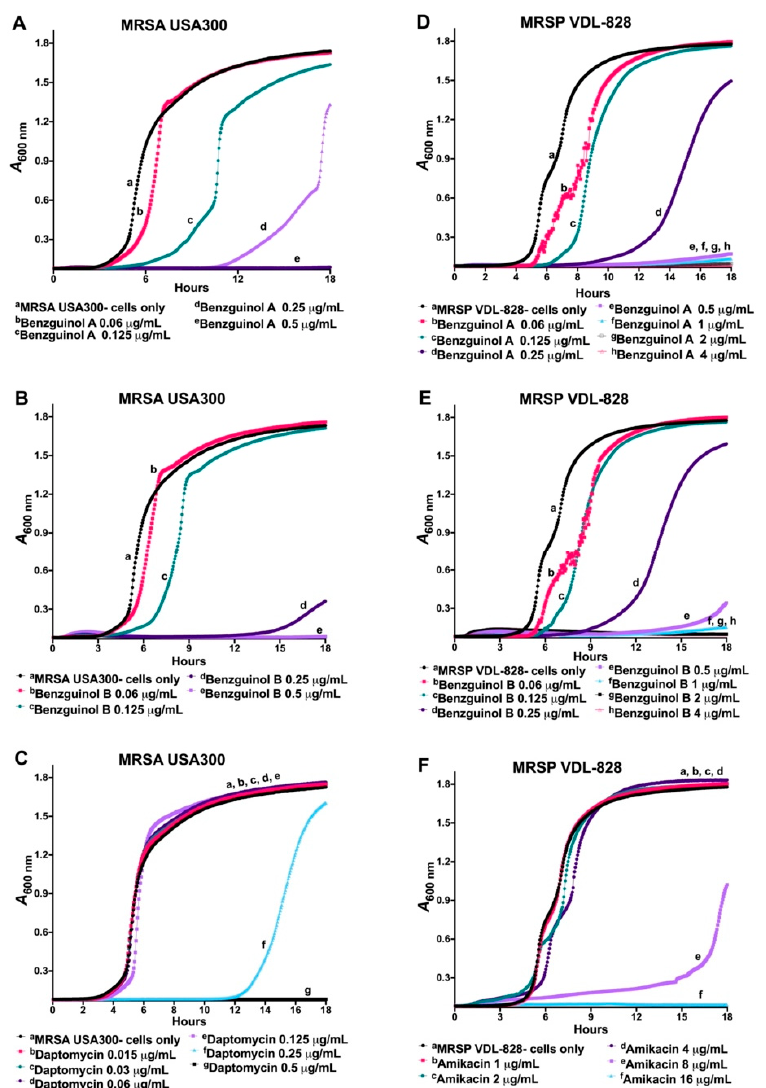
Figure 2. Kinetic assay showing time and concentration-dependent inhibition of MRSA USA300 ( A – C ) and MRSP VDL-828 ( D – F ) for benzguinol A ( A , D ) and benzguinol B ( B , E ) using daptomycin ( C ) and amikacin ( F ) as control drugs . The sub-minimum inhibitory concentrations for benzguinols A and B = 0.25 μ g/mL; daptomycin = 0.25 μ g/mL; and amikacin = 8 μ g/mL.